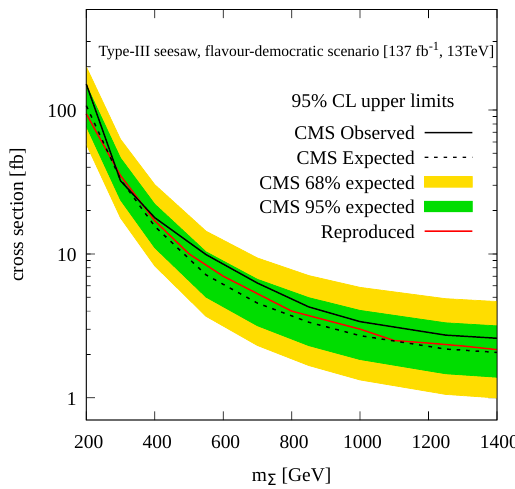
Figure 10 . The 95% CL upper limits on the total production cross section of heavy fermionic pairs in the flavour-democratic scenario in type-III seesaw model using the CMS search [39]. The reproduced 95% CL upper limit is represented by red solid line.